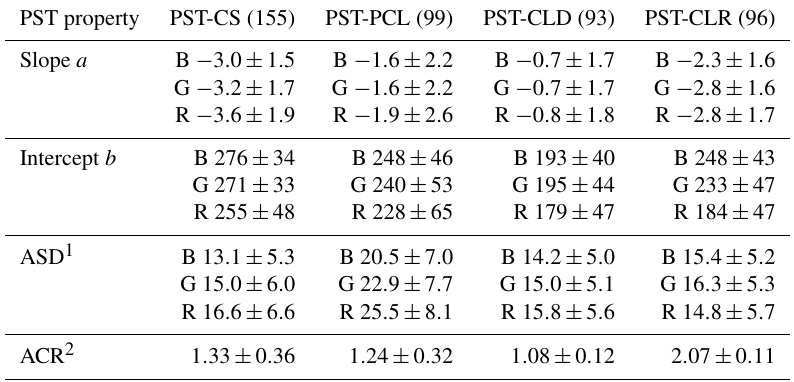
Figure 4. Average radial intensity of the red channel is shown versus radial distance s , measured in LSM units, for the two images of Fig. 2, halo at left. (a) includes the average intensity I (s) , a linear fit, and the running average I 6 (s) as averaged over a width of 6 LSM units. (b) shows the radial intensity deviation η(s) . The halo signal is visible as a minimum at 17 LSM units, followed by a maximum at 21 LSM units in the left column. Table 3. Discriminant properties used to classify the photographic sky type. Averages and standard deviations for the training set of each class are listed. All units are based on color intensity values and LSM units. The number of records for each sky type is indicated in